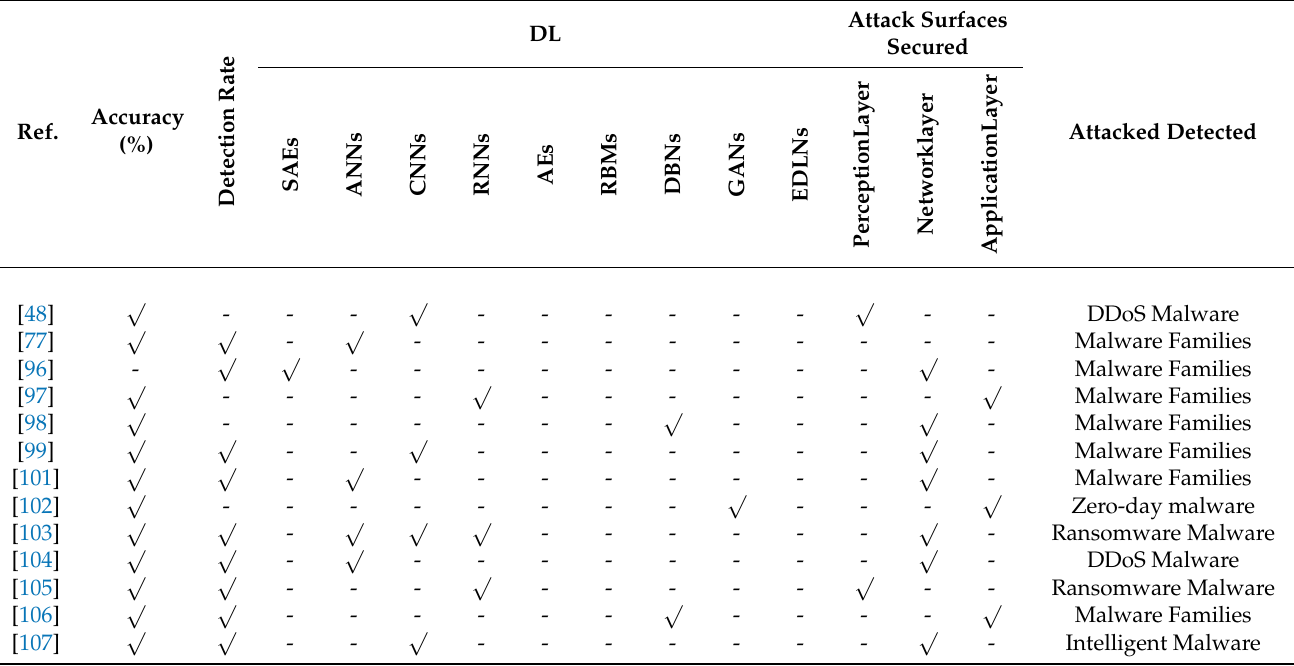
Table 7. Comparison of related work on DL for malware detection in IoT.